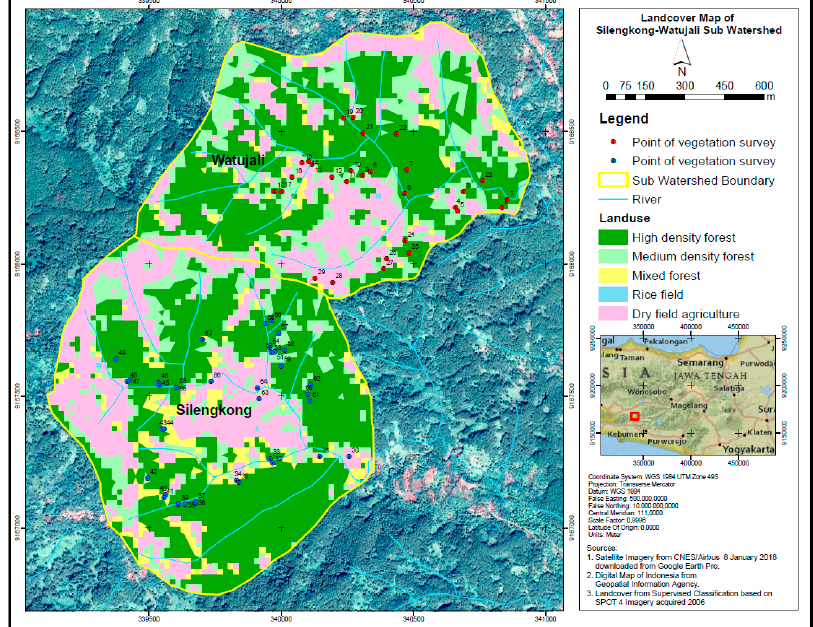
Figure 1. Map of the paired catchment of